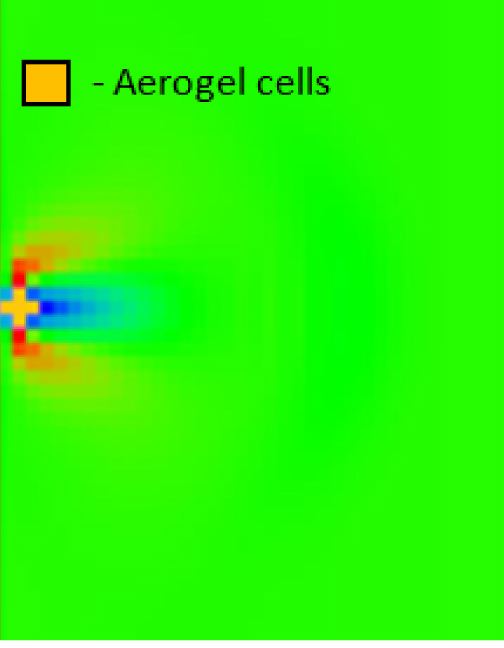
Figure 13. Flows visualization in the model nasal cavity during the deposition of an aerogel particle. Color gradient from red to blue through green shows flow velocity in cell from high to